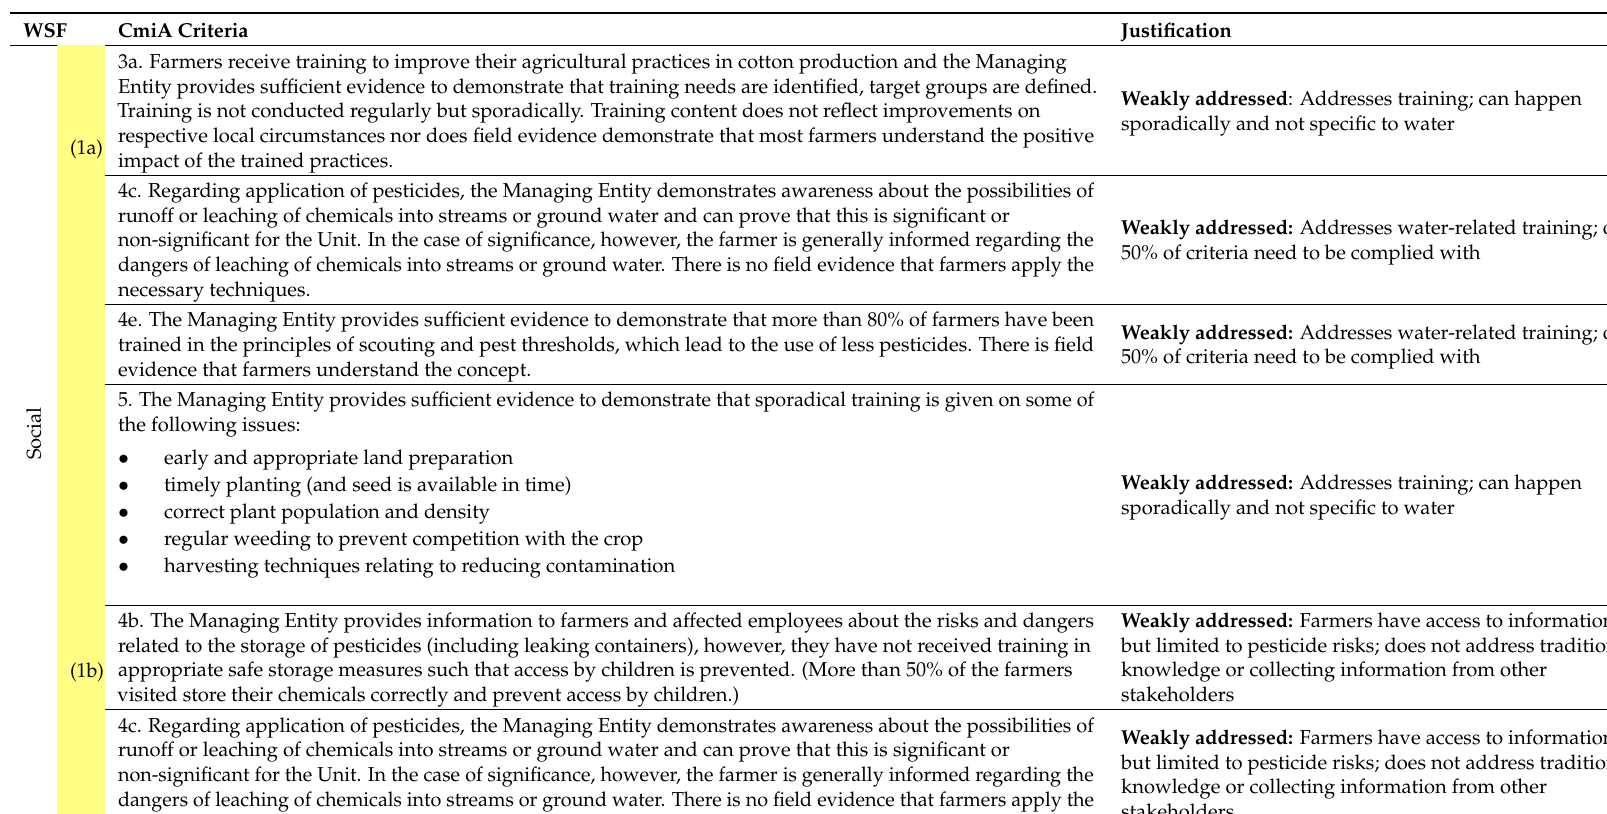
Table A3. Cotton made in African